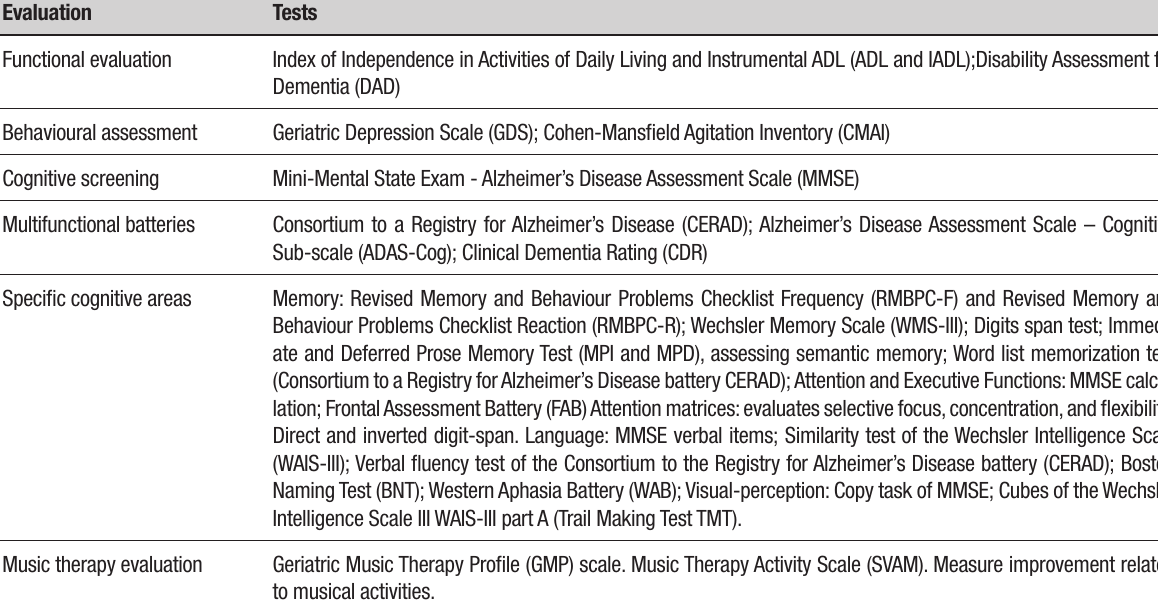
Table 3. Tests used by type of